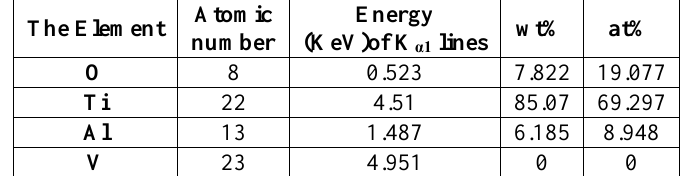
Table 1: Concentration of anodized Ti-6Al-4V alloy elements determined by EDS